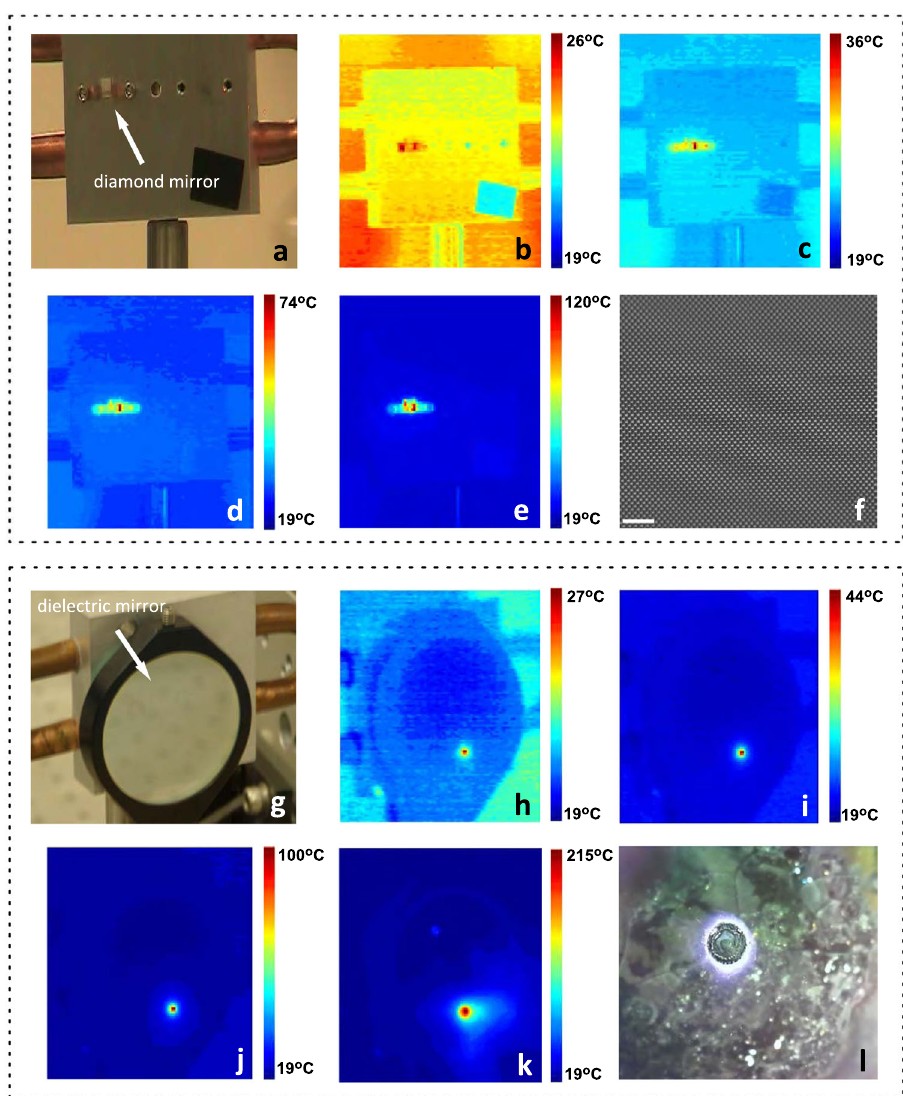
Fig. 4 Laser-induced damage testing of diamond and dielectric mirrors. a Optical image of a diamond mirror mounted on a water-cooled stage that was taken prior to testing. b – e Thermal images of the diamond mirror irradiated by 0.5, 2.5, 5, and 10 kW, respectively, of continuous-wave laser power. Color bar shows the temperature of the setup with varying scale for each image. Temperature accuracy is ±2°. Hot spot corresponds to the position of the beam (on the diamond mirror). At increased power levels a small fraction of optical power leaking through the backside of the diamond mirror results in heating of the stage. f Wide-area SEM image of the diamond mirror shows no damage after testing. Scale bar is 5 μ m. g Optical image of a corresponding